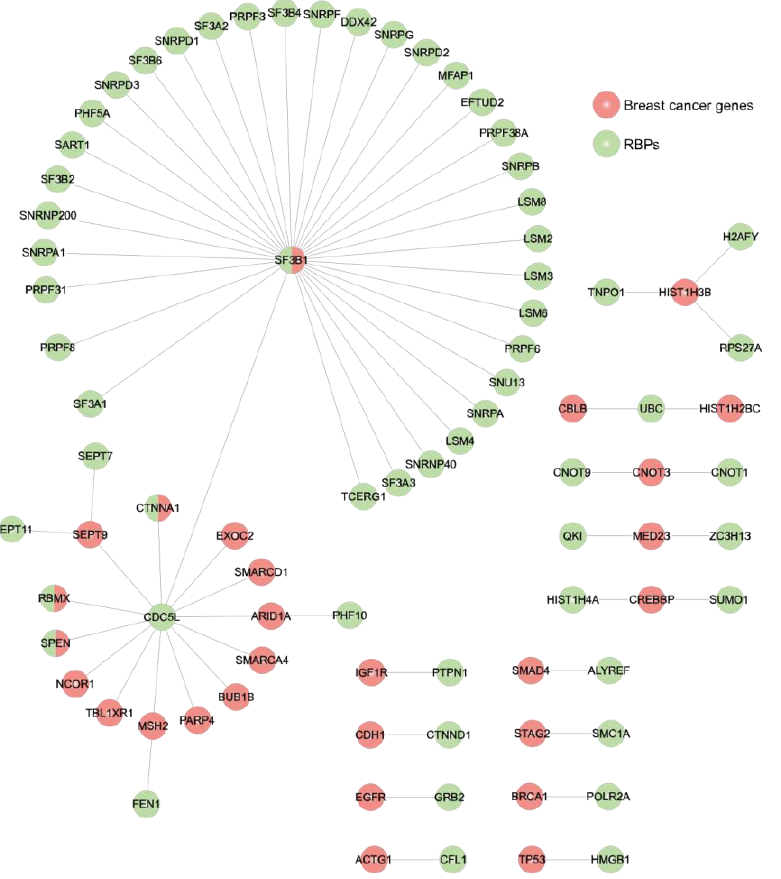
Figure 4. Experimental protein–protein interactions between RNA-binding proteins and well-known breast cancer proteins. An interaction network, constructed using STRING database and the Cytoscape 3.7.1 platform, is presented: red, BC proteins; green, RBPs.